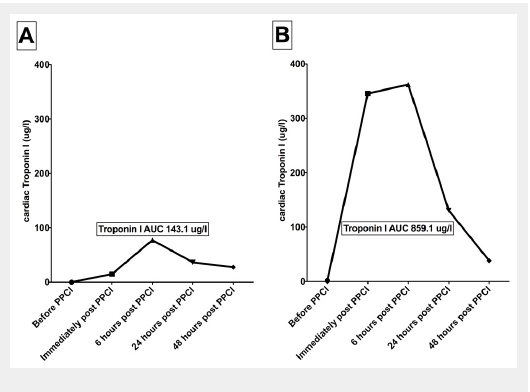
Troponin I curves of two patients with anterior ST-elevation myocardial infarction Both patients had occlusion of the proximal left anterior descending artery and similar symptom-to-balloon times. The ECGs of patient A are presented in figure 2A and the ECGs of patient B are presented in figure